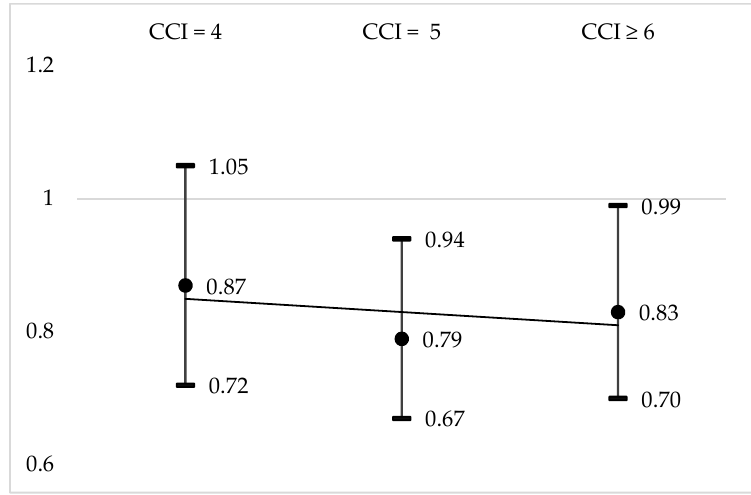
Figure 2. Adjusted odds ratio (95% Confidence interval) of risk of mortality in vaccinated versus non-vaccinated groups according to age (trend line in grey).